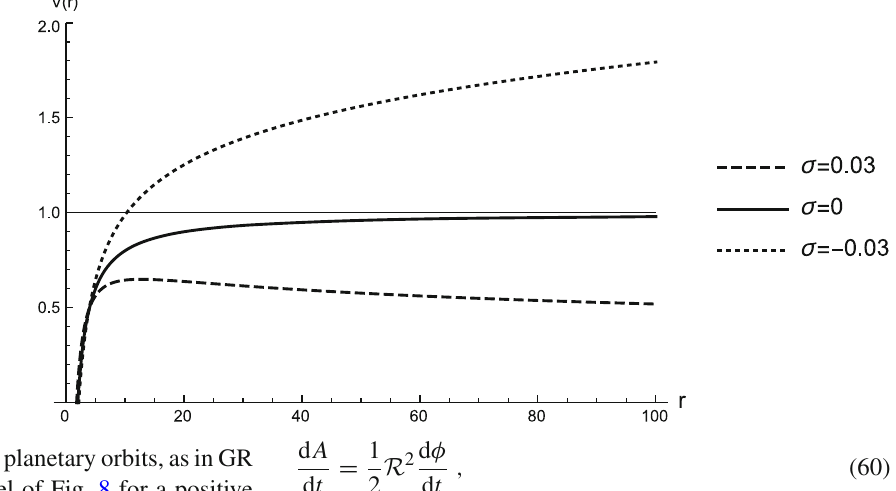
Fig. 6 The behavior of the effective potential for particles V(r) as a function of r , for different values of σ , r S = 2 and L = 0. For σ = 0 the potential V ( ∞ ) = 1, for σ < 0 the potential V ( ∞ ) = ∞ , and for 0 < σ < 1 / 4 the potential V ( ∞ ) =